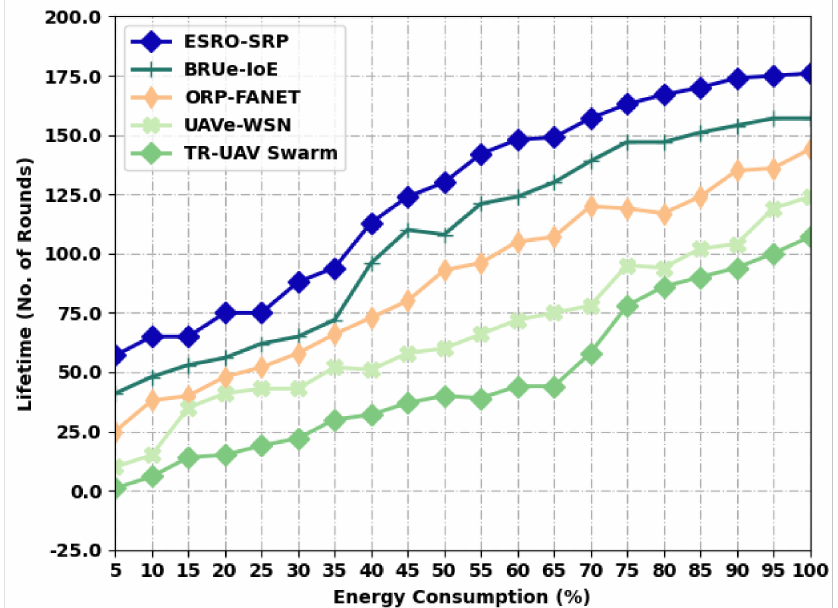
Figure 6. Lifetime analysis of ESRO-SRP technique under distinct levels of